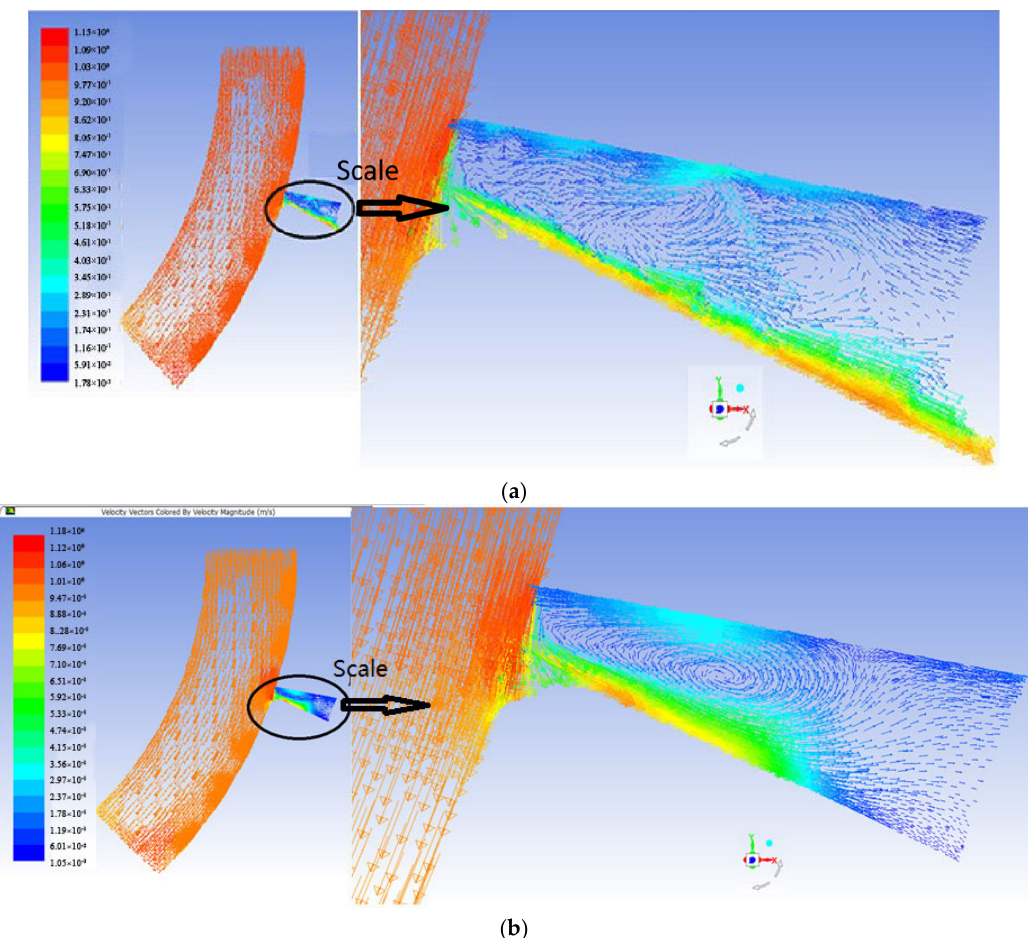
Figure 4. Distribution of velocity vector ( a ) ideal and ( b ) viscous fluid.